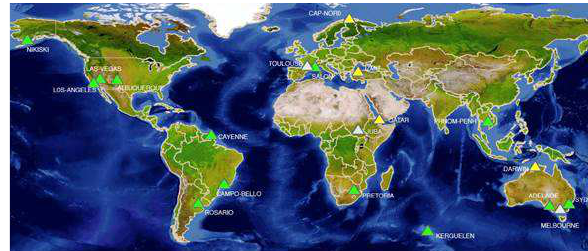
Figure 4. Position of sites used to measure BDPHR geolocation performance.